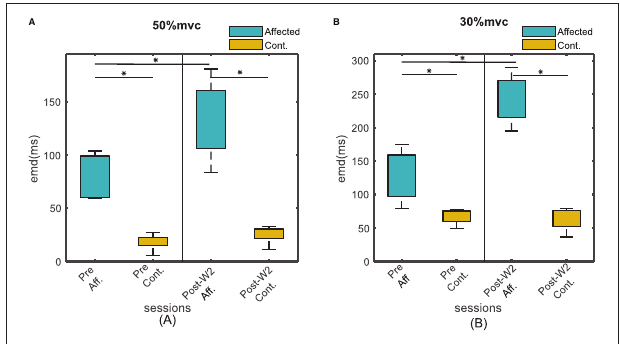
FIGURE 4 | The EMD values for all the subjects for affected and contralateral side, before and after the injection during Post-W2. The sides are plotted with different color during (A) 50% and (B) 30 % contraction. The box height represents the interquartile range of the EMD values for all the subjects. Statistical significance ( p < 0.05) is indicated by